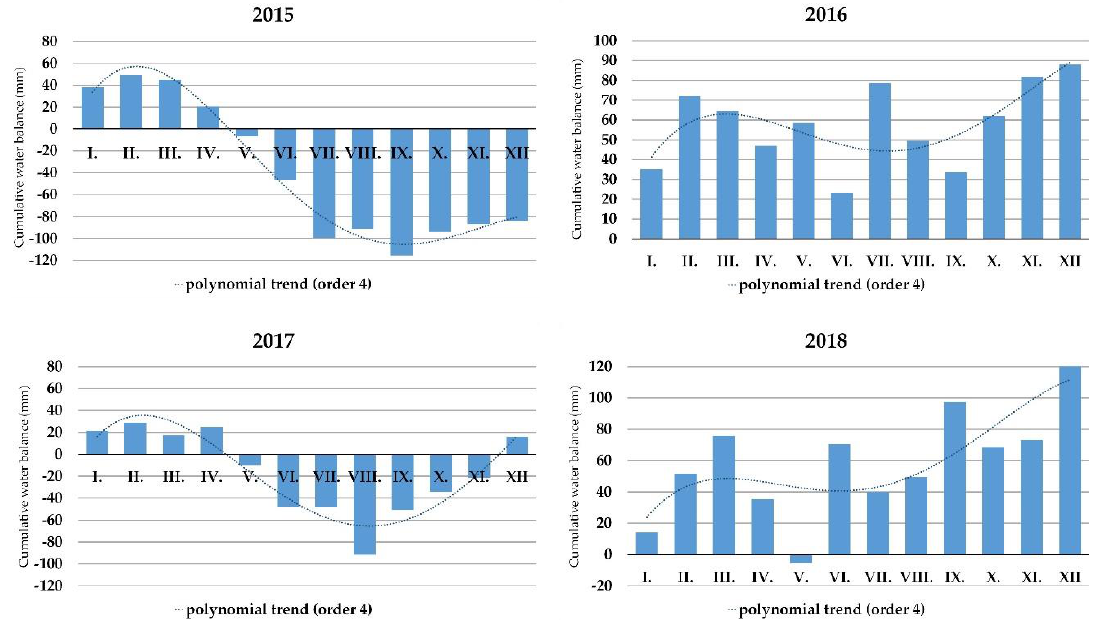
Figure 5. The cumulative water balance for the locality of Báb (southwestern Slovakia) in 2015, 2016, 2017 and 2018.